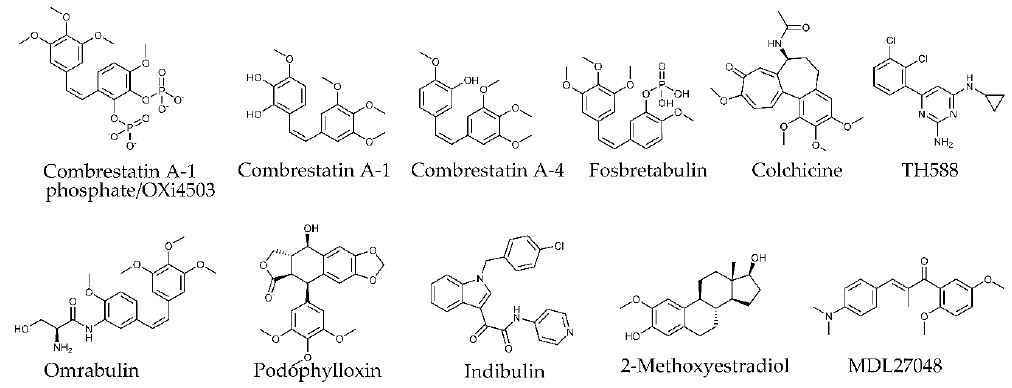
Figure 7. Structure of colchicine, combretastatin A-1, combretastatin A-4, OXi 4503, fosbretabulin, ombrabulin, 2-methoxyestradiol, chalcone: trans-1-(2,5-dimethoxy)-3-[4 (dimethylamino) phenyl]-2- methyl-2-propen-1-one (MDL 27048), podophyllotoxin, indibulin, and TH588.